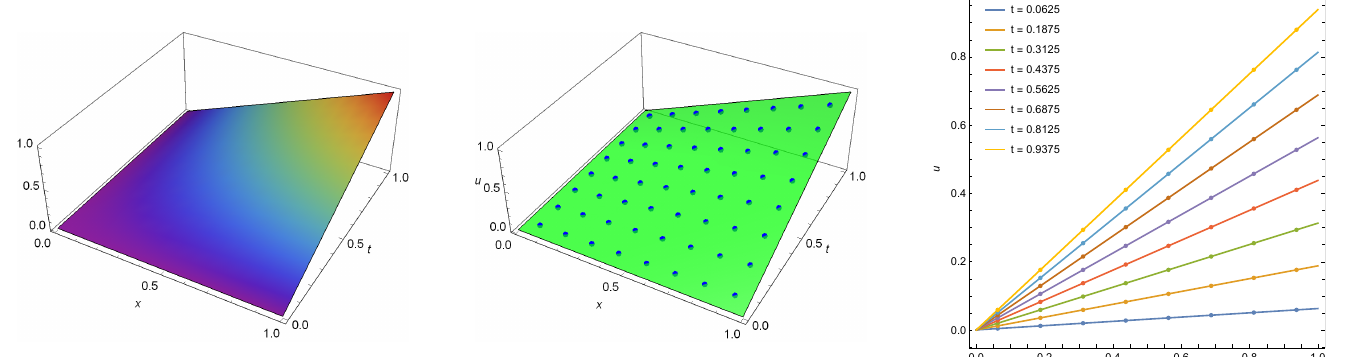
Figure 6. The exact solution ( left ) and numerical solution (points) with exact solution ( middle and right ) computed for Example 4 with M = 8, µ = 1, α = 3 / 2.